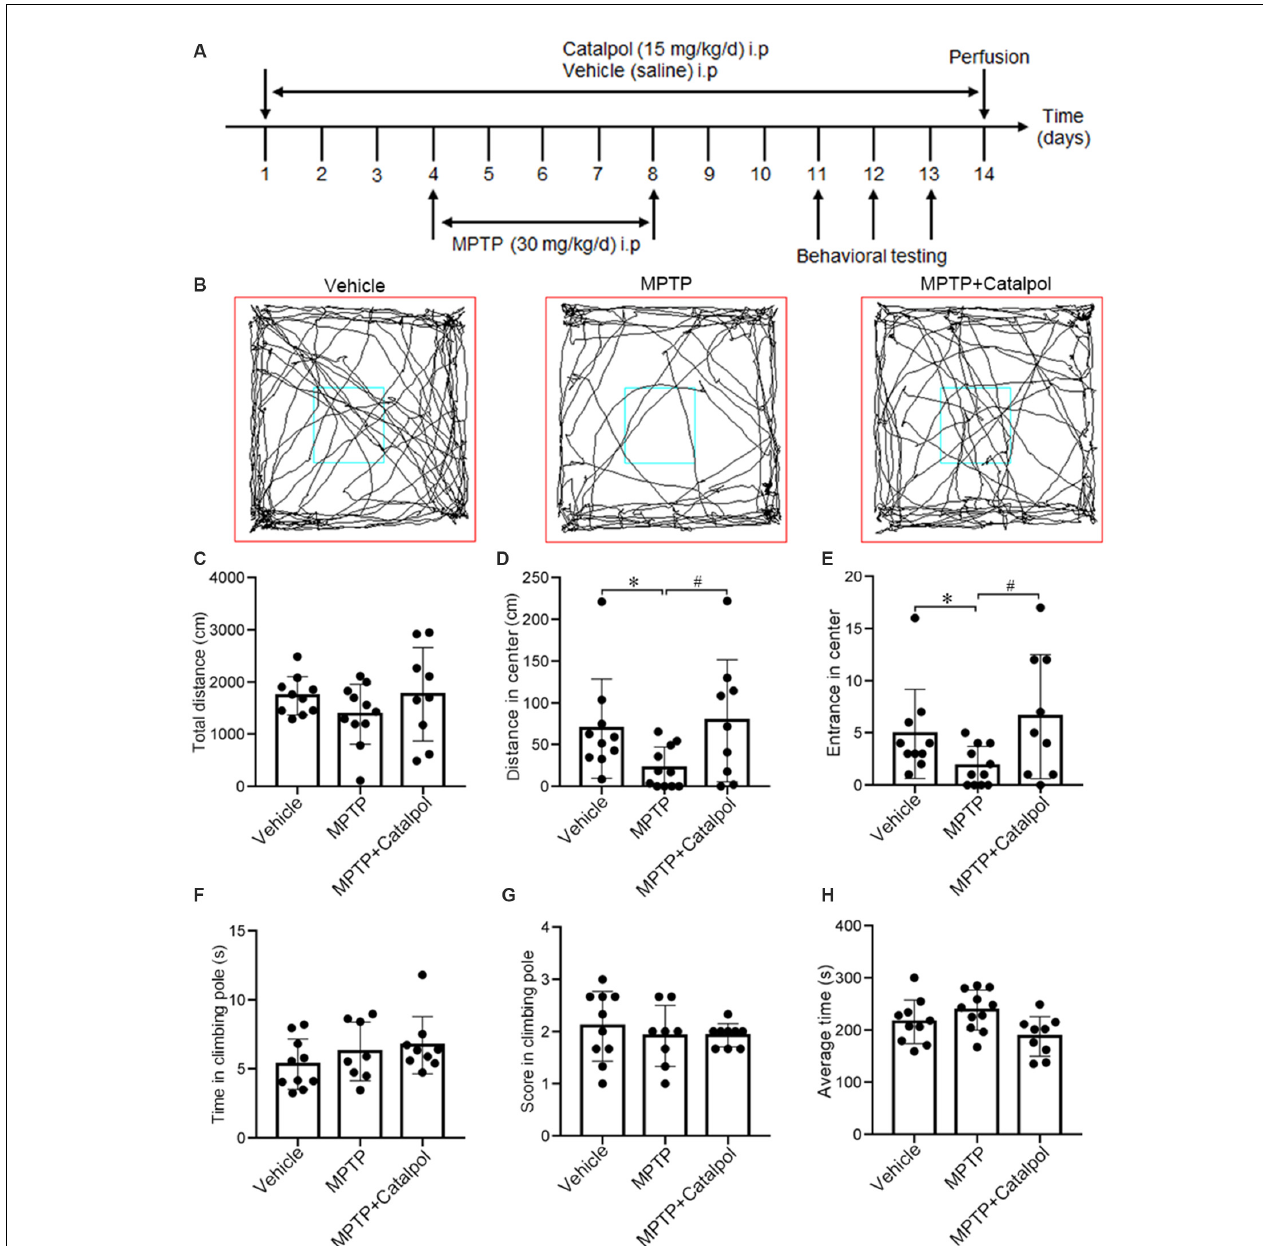
FIGURE 1 | Catalpol alleviates impairment of exploratory behavior in 1-methyl-4-phenyl-1,2,3,6-tetrahydropyridine (MPTP)-treated mice. Mice were intraperitoneally injected with catalpol (15 mg/kg/day) or vehicle (saline) for 3 days, and then administered MPTP (30 mg/kg/day; n = 11), MPTP + catalpol, or vehicle starting on day 4 for 5 days. Mice that were previously treated with MPTP + catalpol ( n = 9) were continually administered catalpol for 6 days; those primed with MPTP received the vehicle for 6 days. Mice treated with the vehicle saline served as the control group ( n = 10). (A) Treatment schedule. (B) Representative images of movement trials in the open field test (OFT). (C) Quantitative analysis of total distance traveled in the OFT. (D) Distance from the zone center. (E) The number of entries into the zone center in the OFT. (F,G) Time and score in the pole-climbing test. (H) The average amount of time mice remained on the rod in the Rotarod test. Data represent mean ± SEM. The P -values were calculated using a one-way analysis of variance (ANOVA). ∗ P < 0.05 vs. vehicle group; # P < 0.05 vs. MPTP-induced group.